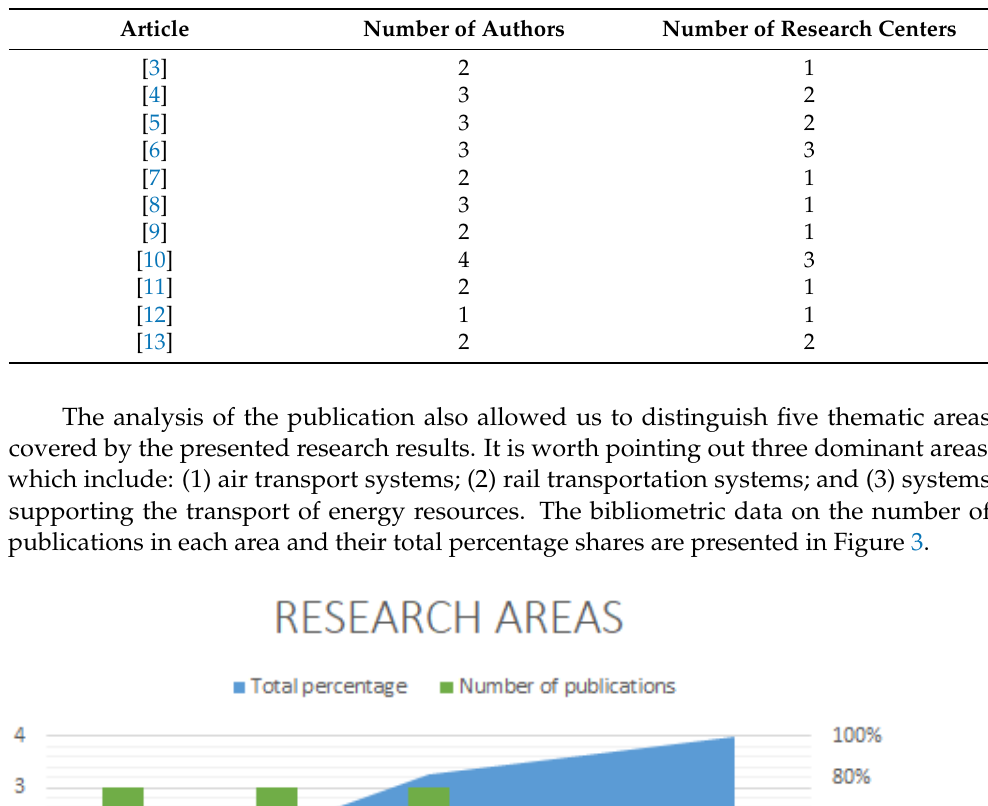
Table 1. List of publications with the number of authors and research centers involved in preparing the publication.